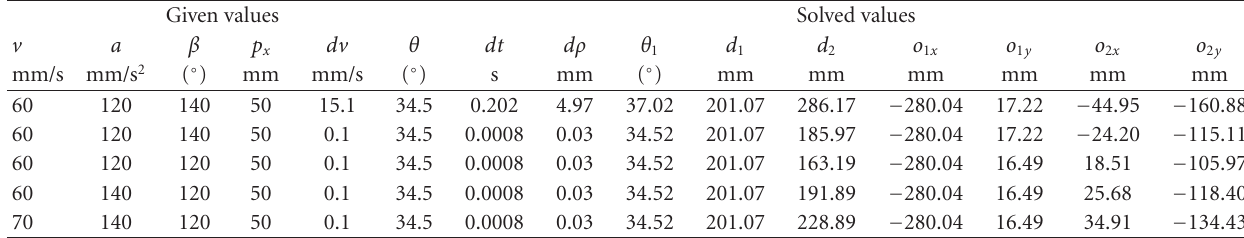
Table 2: Solved results of planar four-bar mechanism as ( ω , l 1 , l 2 , l 3 ) are the same as that in Table 1. Given